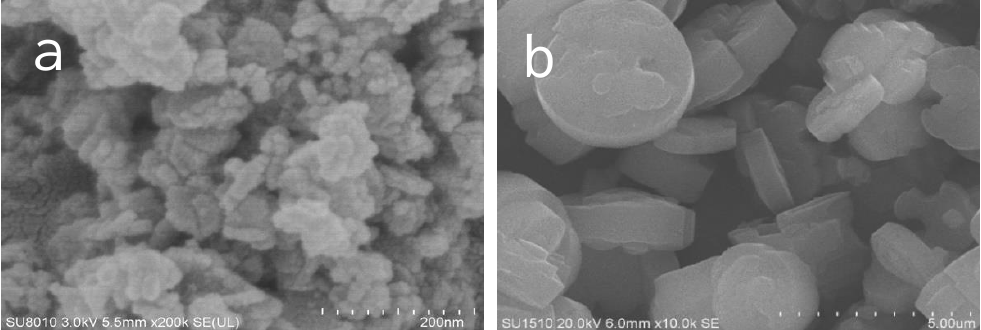
Figure 2. SEM images of as-synthesized ( a ) Fe-LTL-N, ( b ) Fe-LTL-C.